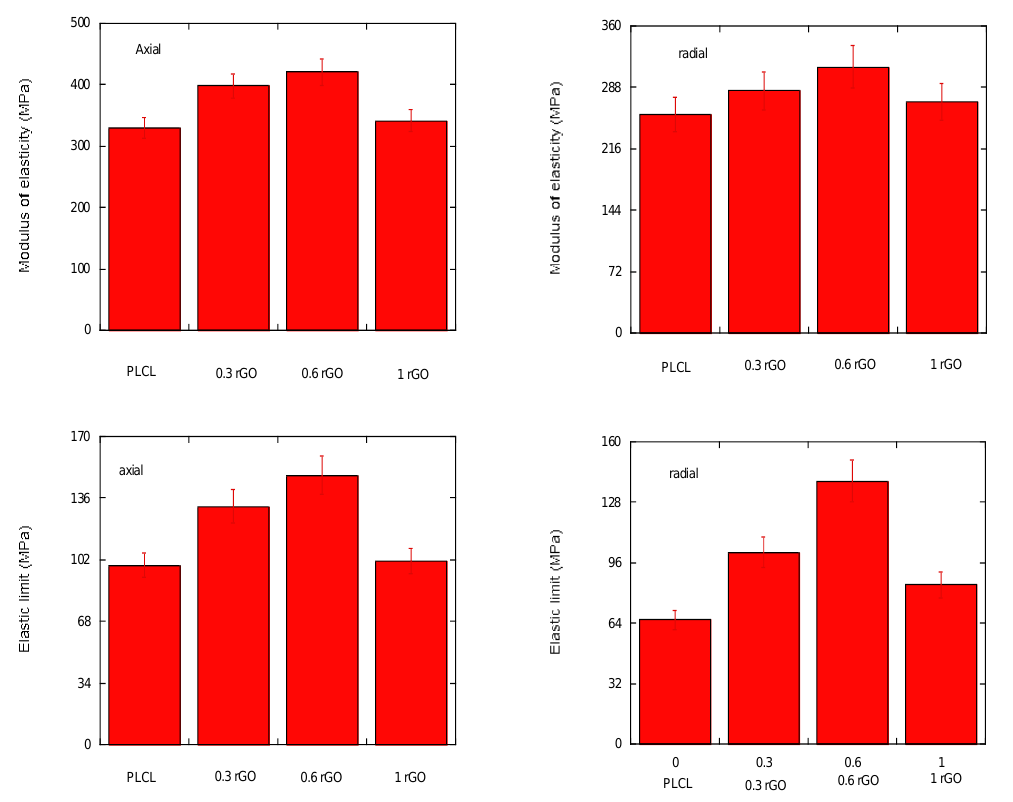
Figure 12. Compressive modulus of elasticity and elastic limit under compression, in the axial and radial direction, for scaffolds made with 0, 0.3, 0.6, and 1% rGO.